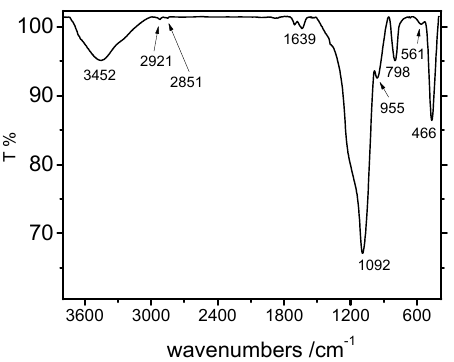
Figure 2. FTIR spectrum of a silica film synthetized by electrochemical methods (100 interferograms, resolution 8 cm − 1 ).